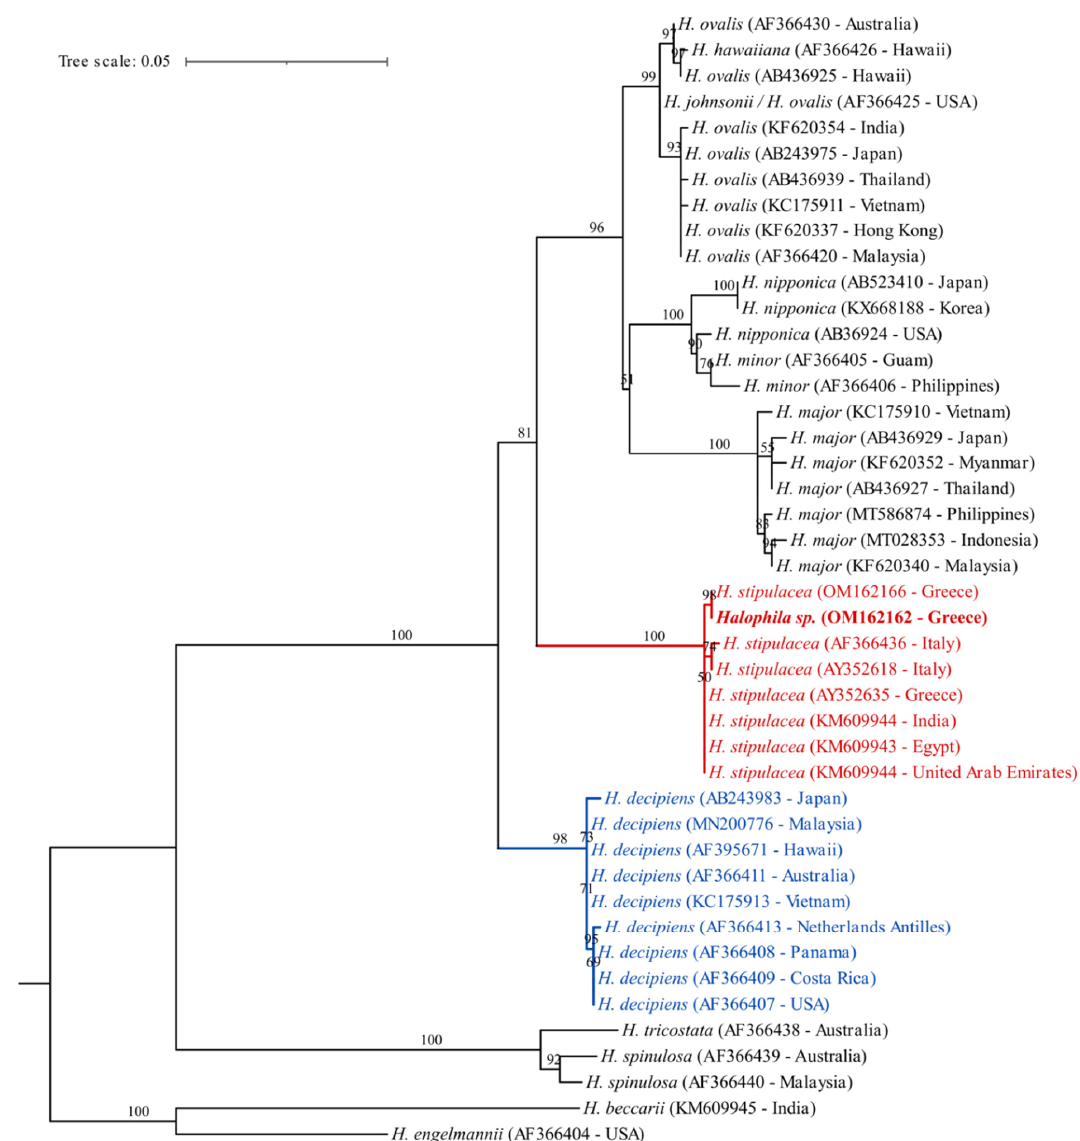
Figure 2. Phylogeny of the Halophila genus inferred from ML analysis based on 44 sequences of 621 bp (including gaps) of the ITS region. The bootstrap values of ML are shown in each node; values < 50 were excluded. The species in bold corresponds to the specimen morphologically identified as H. decipiens found off Salamis, Greece. For sequence AF366425 we included the names H. johnsonii and H. ovalis , since recently a genomic-based phylogenetic and population analysis concluded that given the lack of genetic diversity, the ongoing recognition of H. johnsonii is unsupported and H. johnsonii and should be considered morphological variants of the same species [79]. Furthermore, the H. hawaiiana is currently considered an ecotype of H. ovalis ; therefore, its taxonomic status should be taken with caution until a phylogenomic study takes place. 4. Discussion The Halophila specimens from Salamina Island, morphologically described as H. decipiens ( Halophila sp.) [39], did not show any nucleotide differences in the three DNA barcodes (ITS, rbcL, and matK) when compared to the H. stipulacea specimens from Crete,